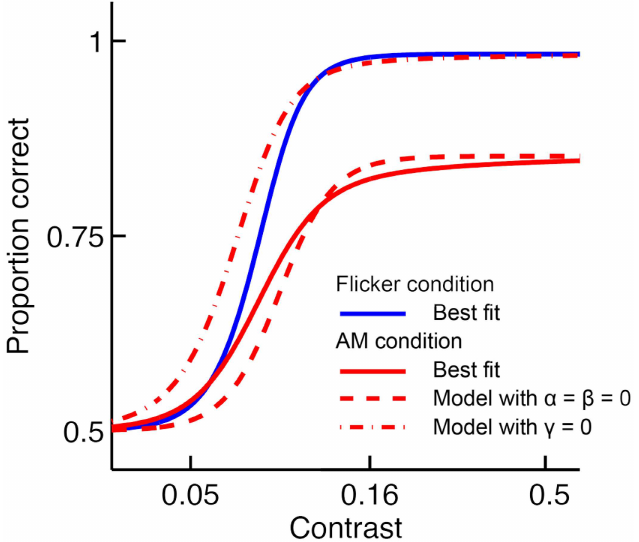
Fig 5. Comparison of contrast normalization models in capturing AM masking. The pooleddata of five observers are shown for the conditionin which the orientationof target and inducers is identical.The predictions of the best-fitting contrast normalization model includingAM-induced effects is indicatedby the full red line (AM condition) and full blue line (Flicker condition).The dashed line shows the model prediction for the AM conditionwhen excitation and divisiveinhibitioneffects are removed after fitting ( α = β = 0). The dash-dotted line represents the predictionwhen the suppression effect is set to zero after fitting ( γ = 0). In contrast to the model without excitation and divisiveinhibition,the model without suppression fails to account for the observed masking at high contrast levels. In addition, this model predicts facilitation of contrast detectionat low contrast levels, which is not supportedby the data. All three models predict the same performance for the Flicker condition,as all parameters controllingAM effects ( α , β and γ ) are set to zero for this